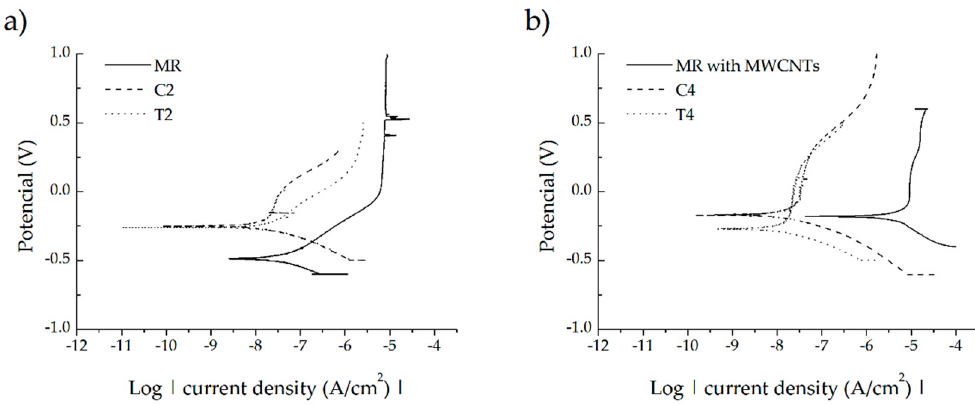
Figure 11. Potentiodynamic polarization curves in Ringer ′ s solution at room temperature of: ( a ) reference sample Ti13Zr13Nb, C2, T2 laser-modified layers; ( b ) reference sample Ti13Zr13Nb with MWCNTs coating, C4, T4 laser-modified layers.